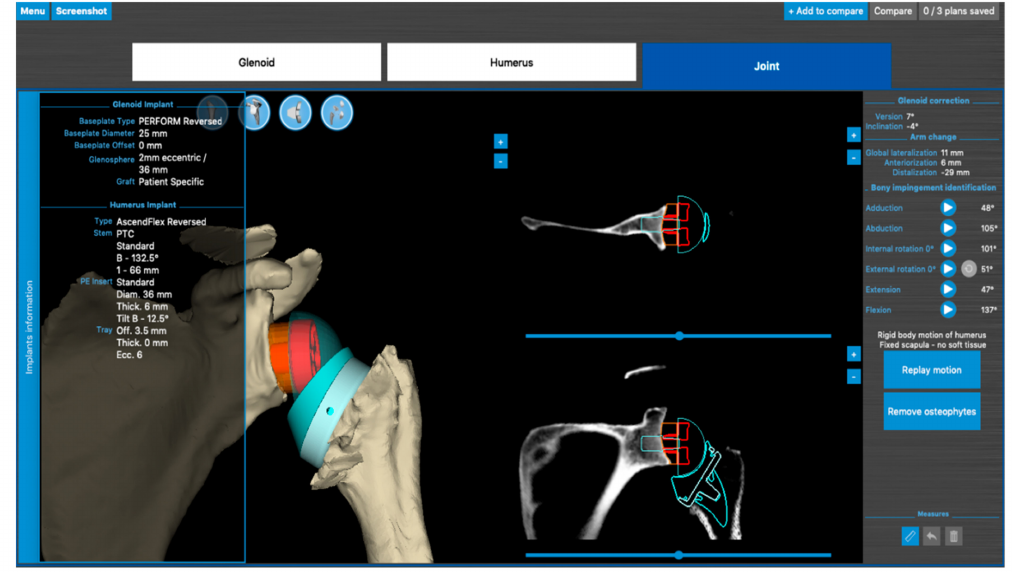
Figure 8. Use of software allowing planning of rigid body motion (Blueprint software, Imascap, Plouzan é ,